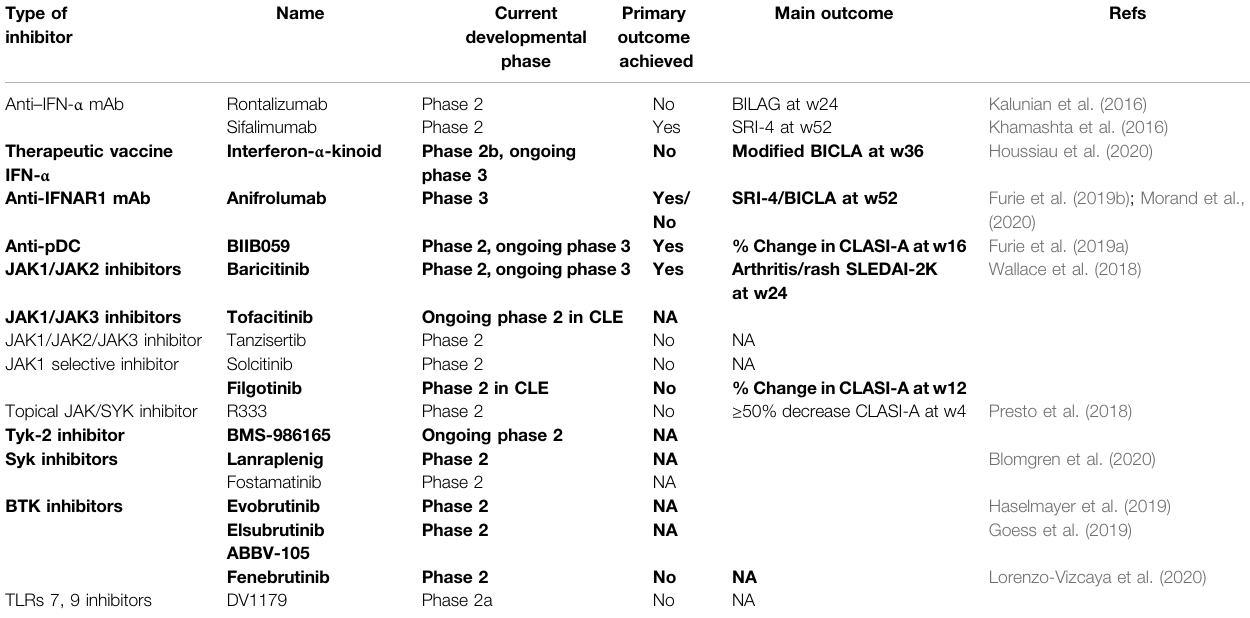
TABLE 3 | Clinical trials of molecules targeting IFN-I, cells producing IFN-I, or IFN-I – related signaling pathways in clinical development ≥ phase two trials in lupus erythematosus. Type of